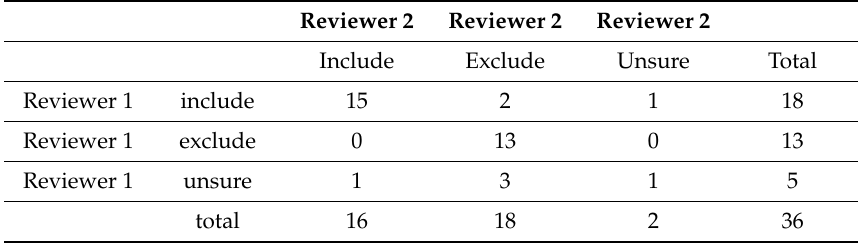
Table 2. K agreement calculation. Proportion of agreement (Po) = 0.855; agreement expected (Pe)